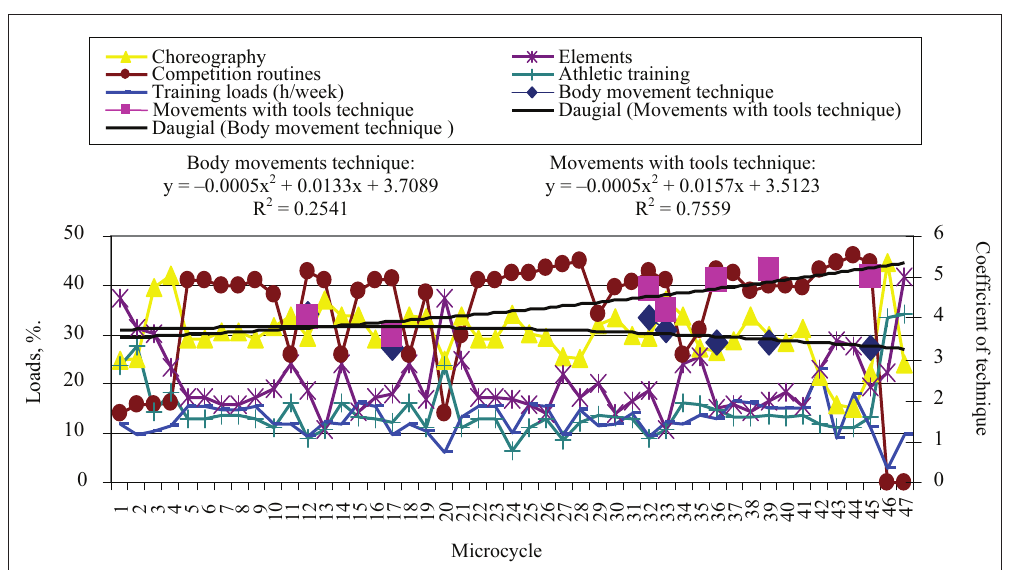
Figure. Changes in the volume of training loads (%) and complexity of the content and technique in the most effective training program in the experiment for 13–14-year-old athletes in rhythmic gymnastics during the macro-cycle performance athletes in rhythmic gymnastics: body movement technique (21.1%), tool technique